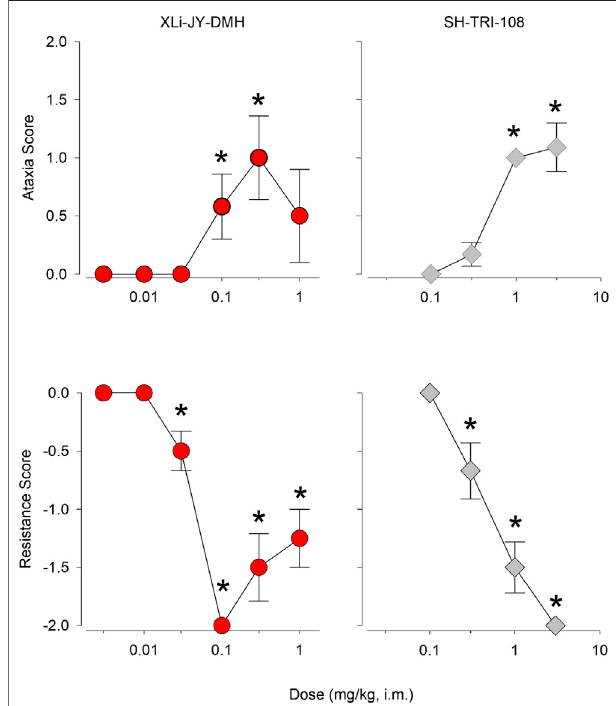
FIGURE 5 | Experimenter-assessed ataxia and muscle resistance (relaxant) scores following i. m. injections of XLi-JY-DMH and SH-TRI-108